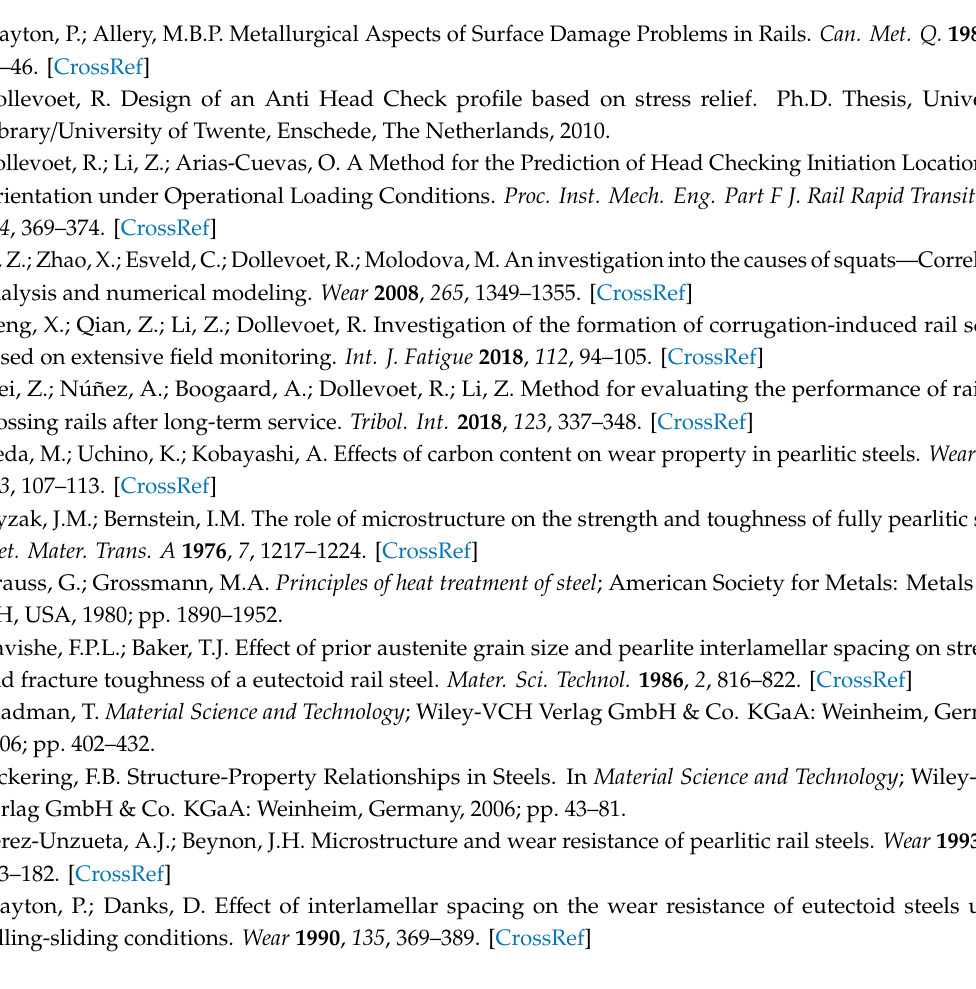
Figure S1: Optical Micrographs of di ff erent steels in non-etched condition ( a ) B360, ( b ) B1400, ( c ) CrB, Figure S2: ( a ) Grain map showing the PAGs for B360-HT, ( b ) PAGs for B1400-HT, ( c ) PAGs for CrB-HT, ( d ) the grain size distribution for all steels, Table S1: PAGS for heat treated